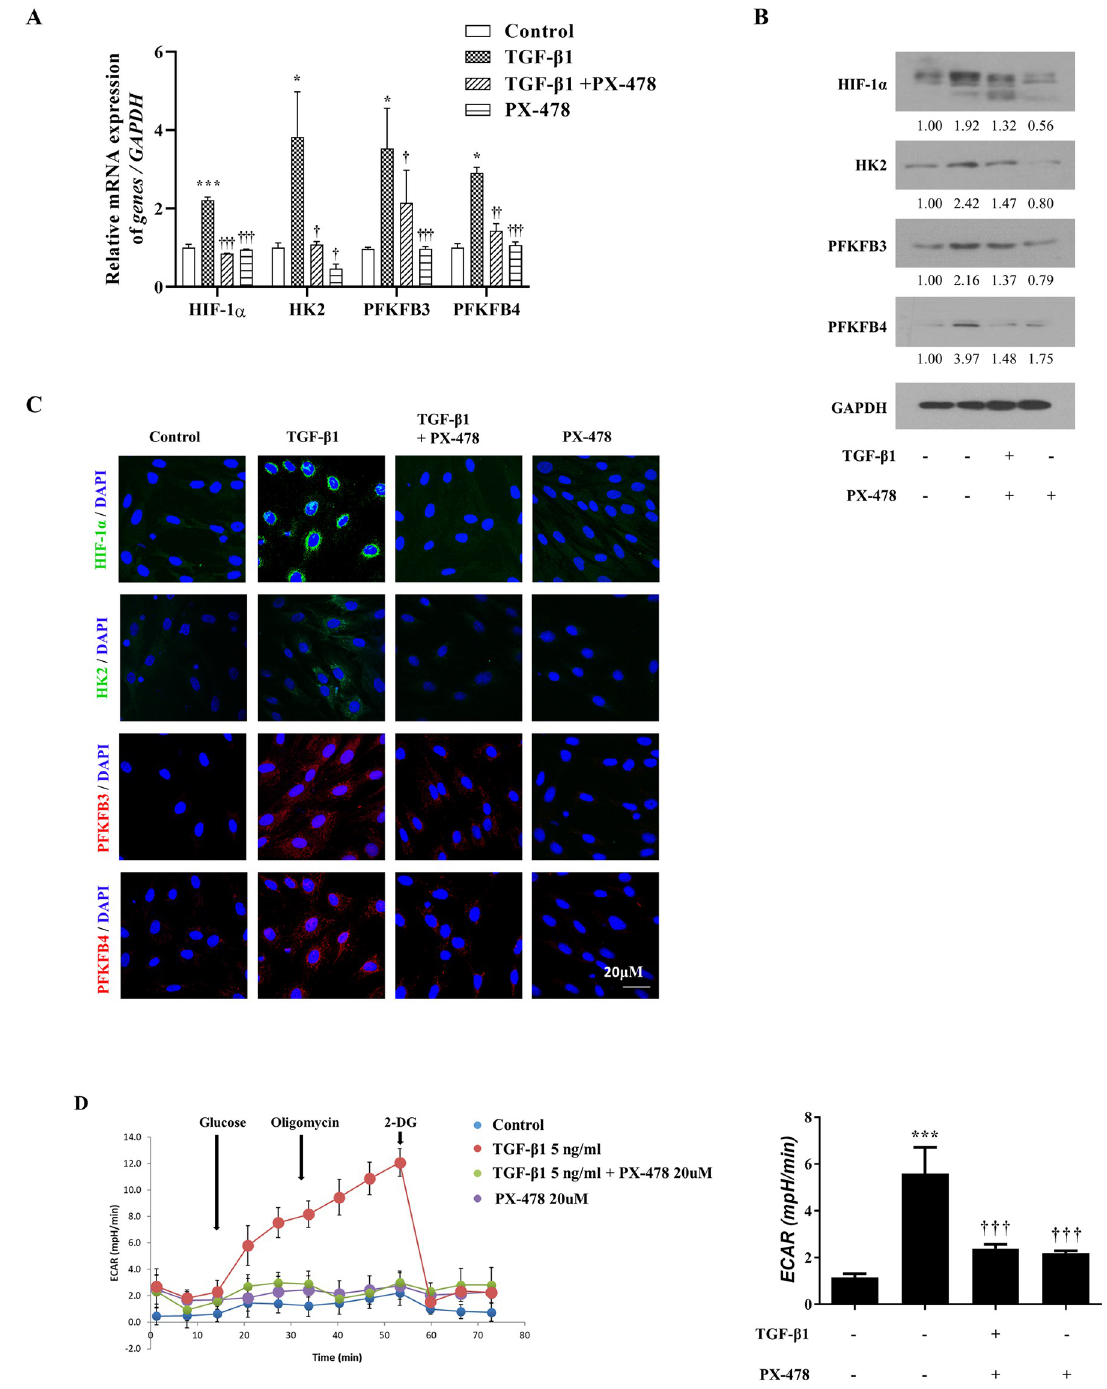
Fig 3. PX-478 decreased the expression of HIF-1 α and glycolytic enzymes, and downregulated glycolytic flux in TGF- β 1-treated nasal fibroblast. (a) Gene expression levels of HIF-1 α , HK2, PFKFB3, and PFKFB4 were confirmed by RT-PCR; and (b) Protein levels were detected by Western blotting; (c) Protein expression and localization of HIF-1 α , HK2 (Green), PFKFB3, PFKFB4 (red), and DAPI (blue) were determined by immunofluorescence staining; (d) ECAR was measured using XFe96. � p < 0.05 and ��� p < 0.001 compared with control using one-way ANOVA test, †p < 0.05, ††p < 0.01, and †††p < 0.001 compared with TGF- β 1 using the one-way ANOVA test.